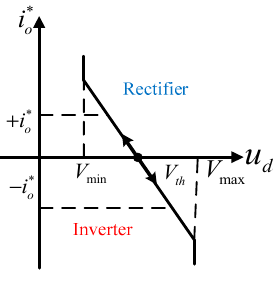
Figure 7. Droop characteristic.